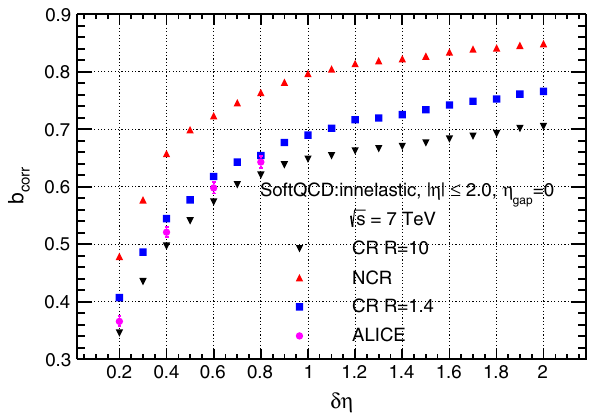
√ s = 7 TeV. for twostrength values